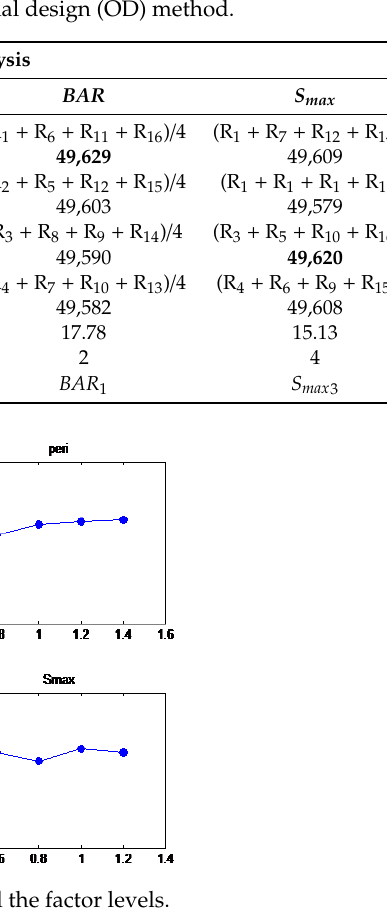
Table 3. Factor analysis with the orthogonal design (OD) method.